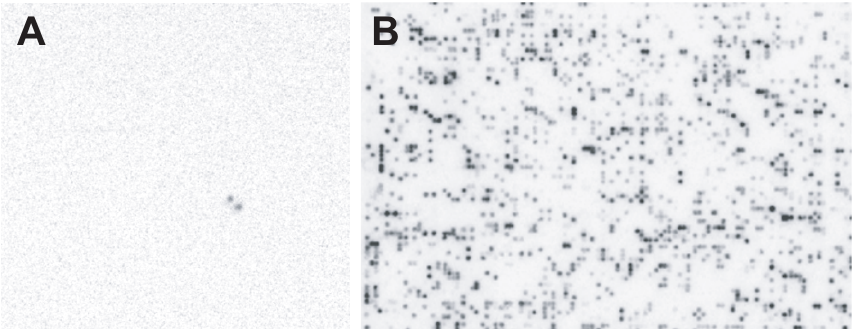
Figure 3. Screening LP 7-56 BAC macroarrays. (A) Use of the BAC library in gene isolation. The autoradiogram shows hybridization of an overgo probe linked to the LEA gene on LP chromosome 10 to a double-spotted BAC clone potentially containing a full length LEA gene. The positive BAC clone, PT_7Ba_00066 J18, was sequenced and indeed found to contain an intact LEA gene. (B) Hybridization of a 4 6 4 membrane with the IFG-7 retroelement. Note that IFG-7 is found in many, but not all BAC clones. Also note that some clones appear to contain higher densities of the retroelement.